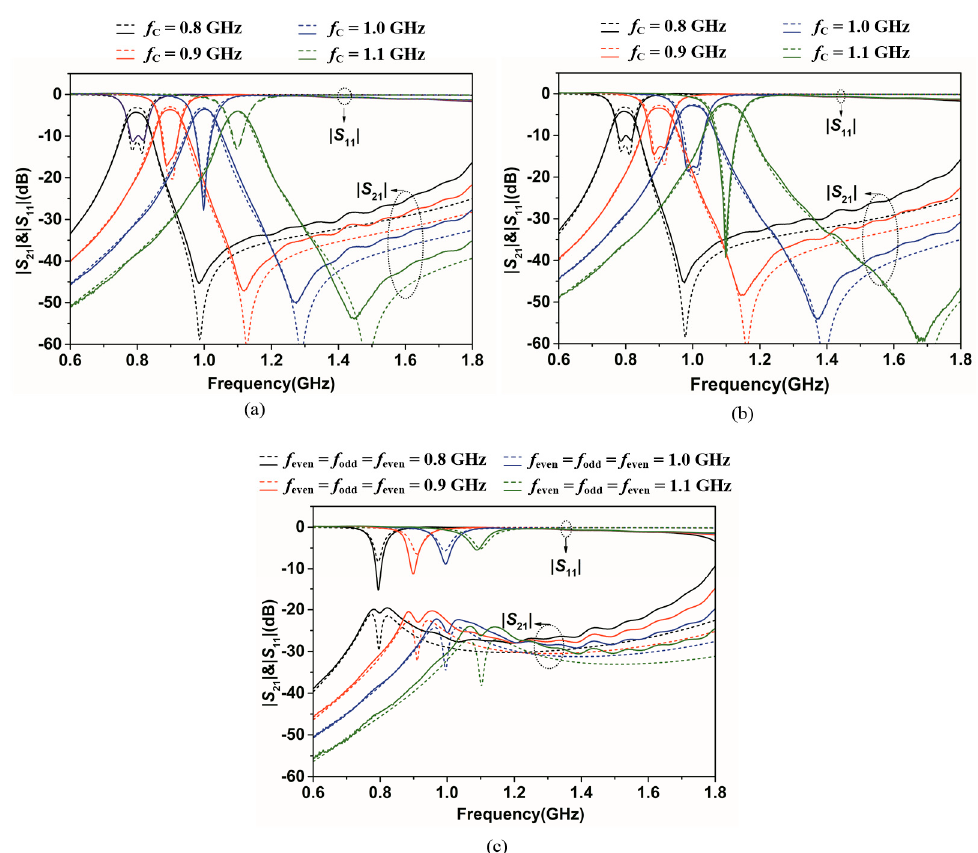
Figure 8. Simulated and measured S parameters for the proposed filter (solid line: measurement; dash line: simulation). ( a ) Center-frequency tuning with 74 MHz CABW; ( b ) center-frequency tuning with 8.5% CFBW; and ( c ) intrinsic switch-off state. Table 3. Comparisons with previously reported switched tunable filter.